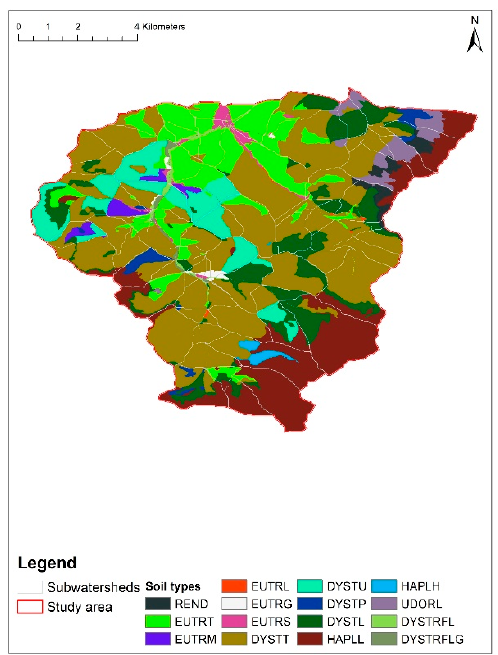
Figure 3. Soil types (REND—Rendoll; EUTRT—Eutric cambisols typic; EUTRM—Eutric cambisols